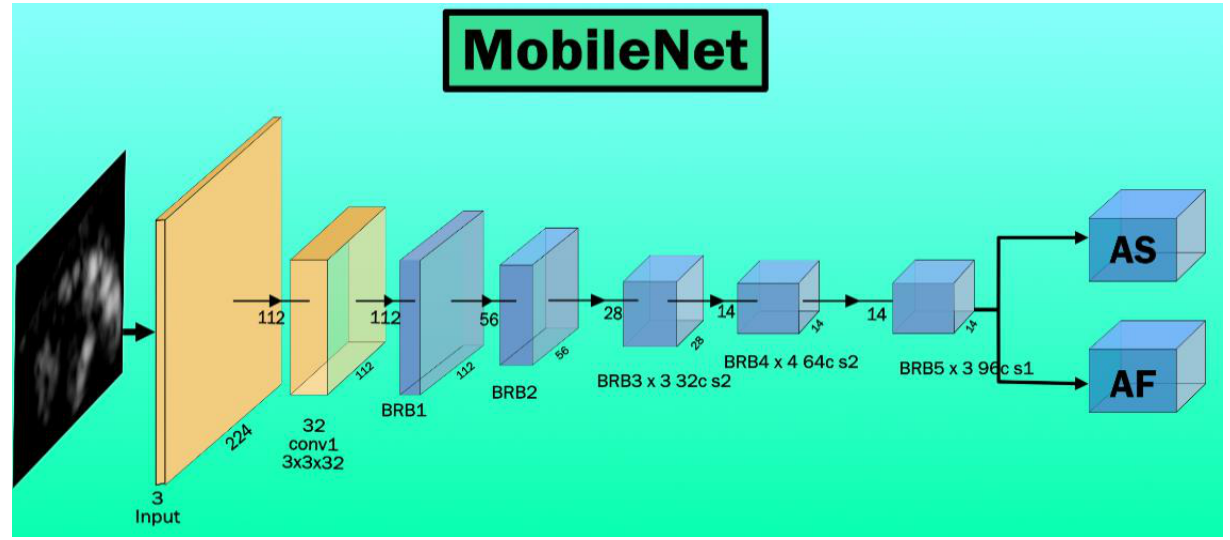
Figure 8. MobileNet Architecture, BRB: bottleneck and residual blocks.